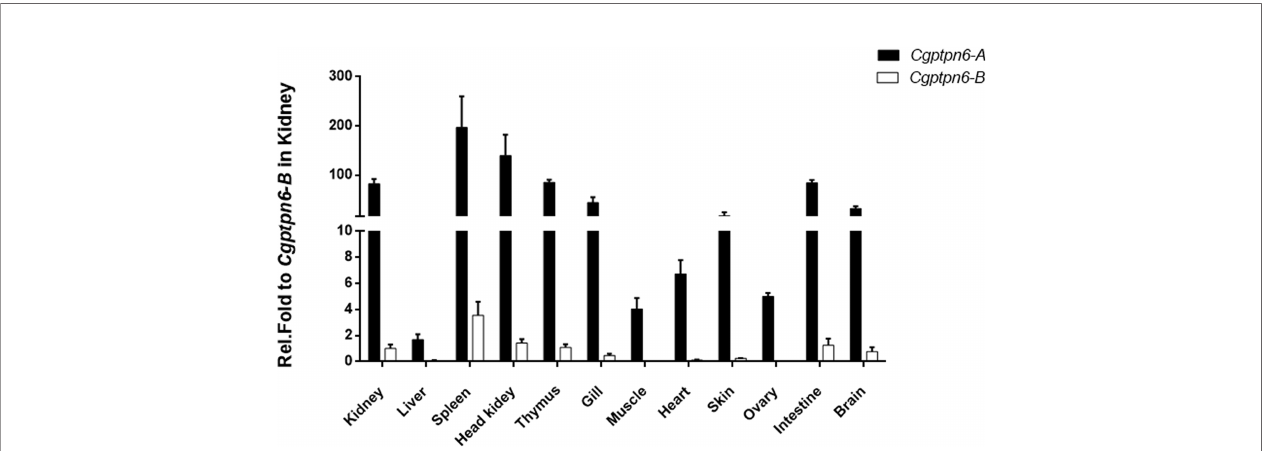
FIGURE 2 | qPCR analysis of Cgptpn6-A and Cgptpn6-B expression in healthy adult tissues. eef1a1l1 was used as control. Each bar represents mean ± standard deviation (SD) (n = 3).